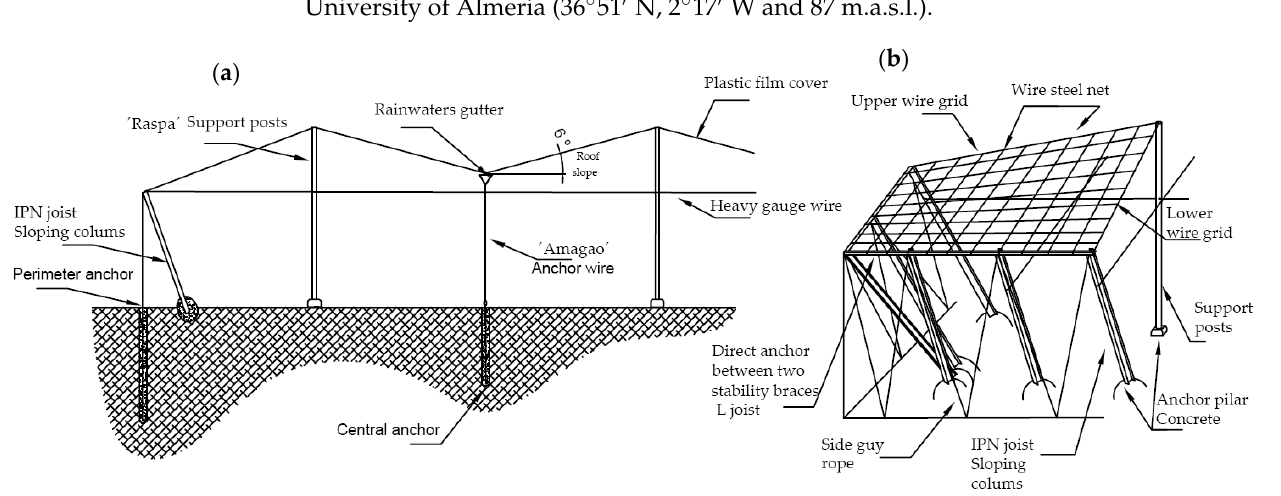
Table 1. Electric conductivity in different irrigation areas in the experiment. T, treatment; S, typical soil substrate “enarenado”; H, coconut fiber substrate.